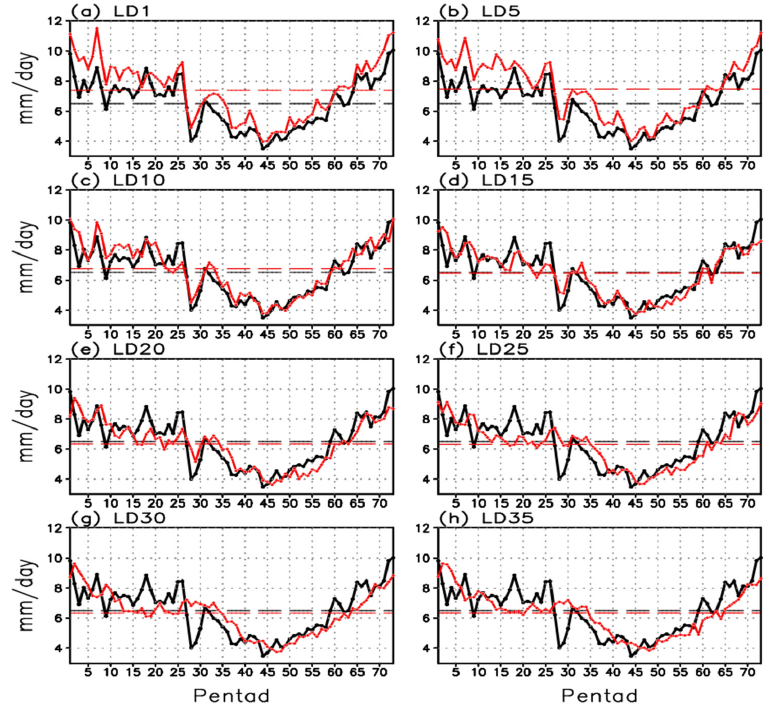
Figure 9. Climatological pentad mean rainfall (mm/day) averaged over the Maritime Continent for observation (GPCP; black line) and CFSv2 predictions (red line) in ( a ) LD1; ( b ) LD5; ( c ) LD10; ( d ) LD15; ( e ) LD20; ( f ) LD25; ( g ) LD30; and ( h ) LD35.